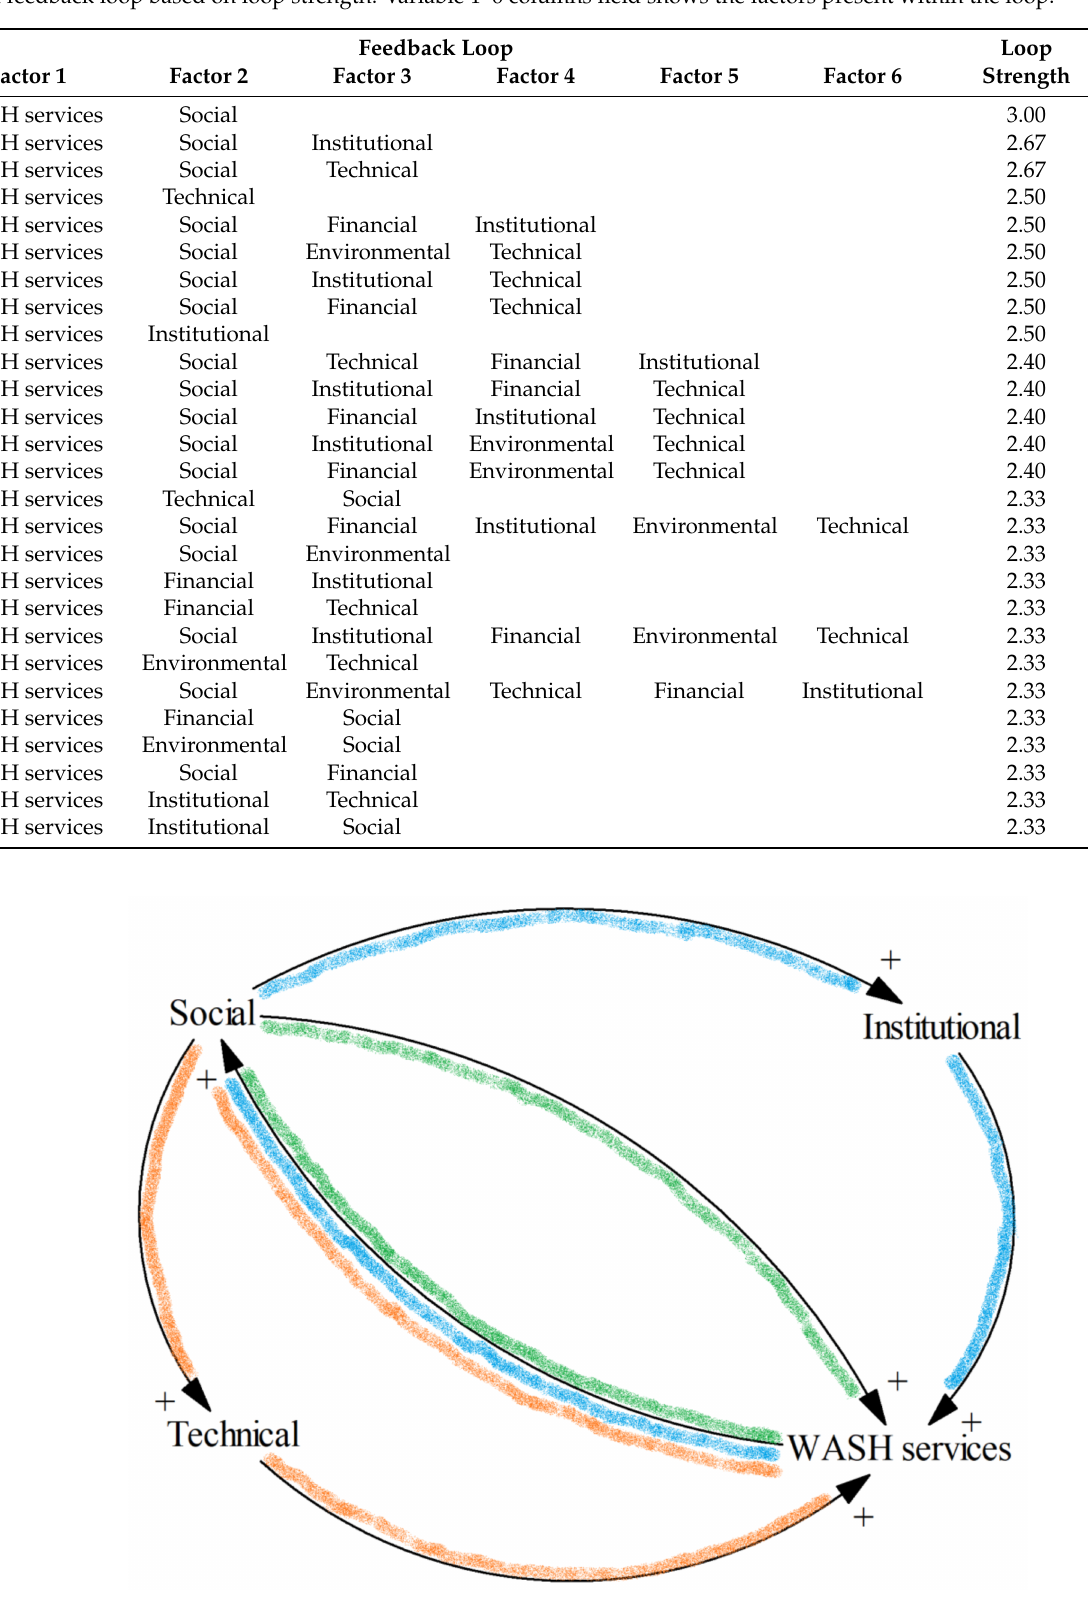
Figure 4. The top three most prominent feedback loops in the system (distinguished by the